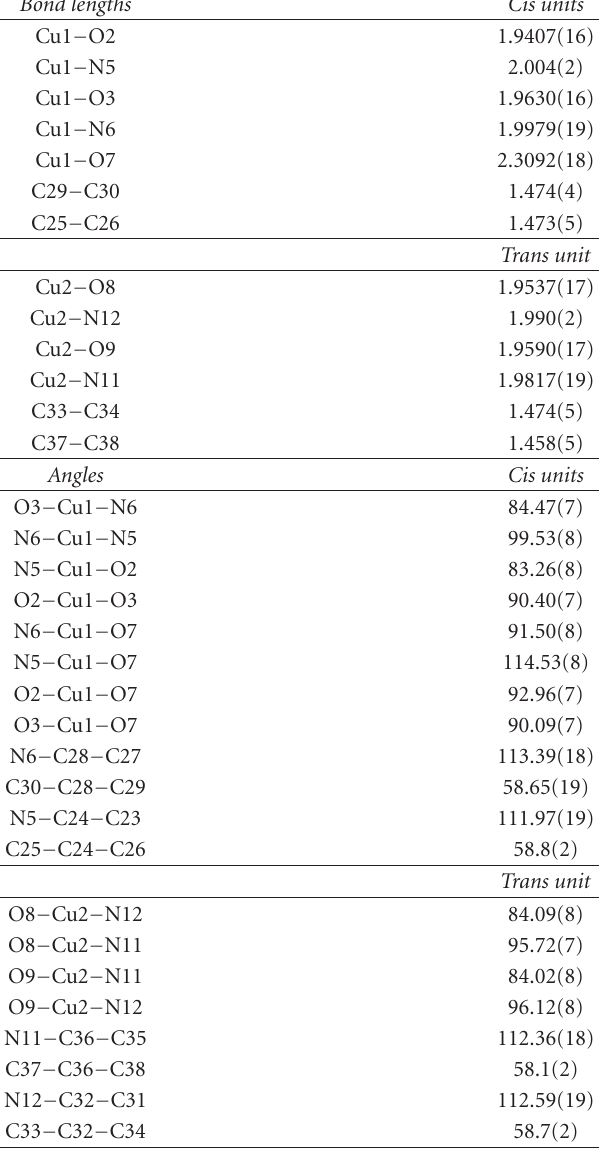
Table 4: Selected bond lengths (˚A) and angles ( ◦ ) for [Cu(ACC) 2 ] 3 · 4H 2 O ( 2 )